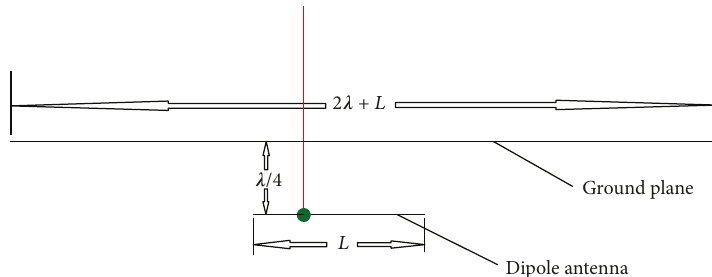
Figure 10: Ground plane o ff set de fi ned for the wing chord study.